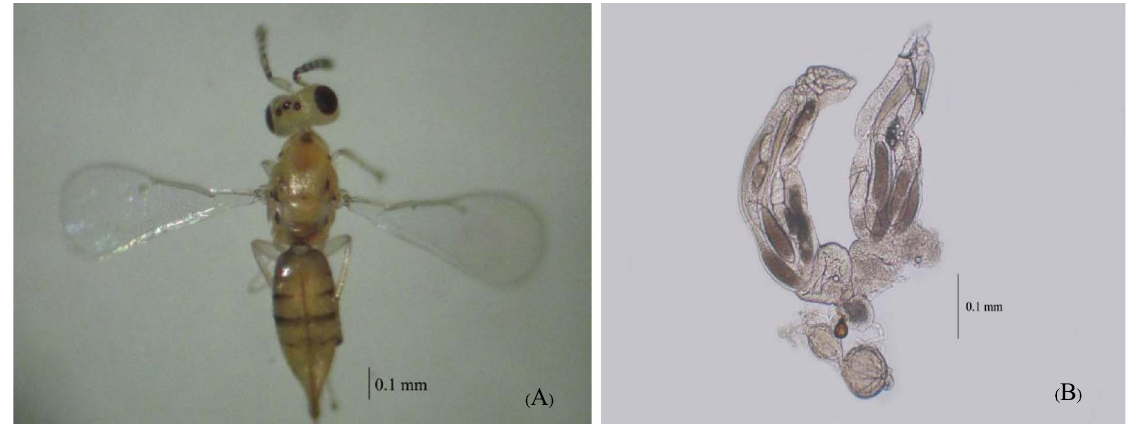
Figure 2. Quadrastichus mendeli ; (A) adult female, and (B) mature eggs in